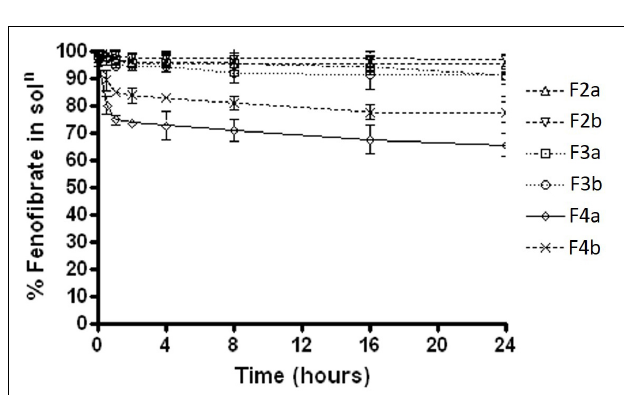
FIGURE 3 | The % fenofibrate in solution during 24 h time after 1:100 dilution in the aqueous media (water) (fenofibrate was dissolved at 80% of the equilibrium solubility in the anhydrous mixture). The formulation represent F2a- C70: CM (7:3)/TO106V (1/1), F3a- C70: CM (7:3)/ HCO-30 (1/1), F2b- K70:I742(7:3)/TO106V(1/1), F3b- K70:I742(7:3)/HCO-30 (1/1), F4a- CMCM/HCO-30 (1/1) and F4b- I742/ HCO-30 (1/1) respectively. Data are presented as mean ± SD, ( n =